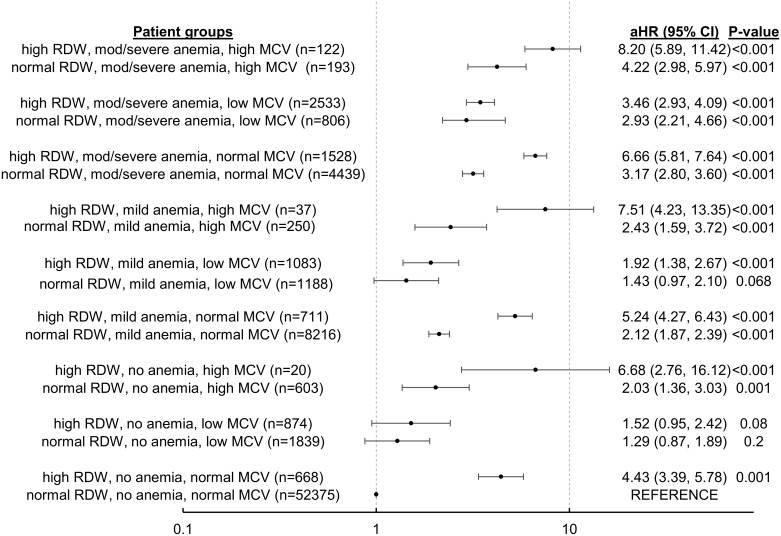
Forrest plot of aHR of 1 year mortality of anemia stratified by MCV and RDW.* adjusted for the same variables as in Table 4. Adjusted Hazard Ratio (aHR); Red Cell distribution Width (RDW); Mean Corpuscular Volume (MCV).